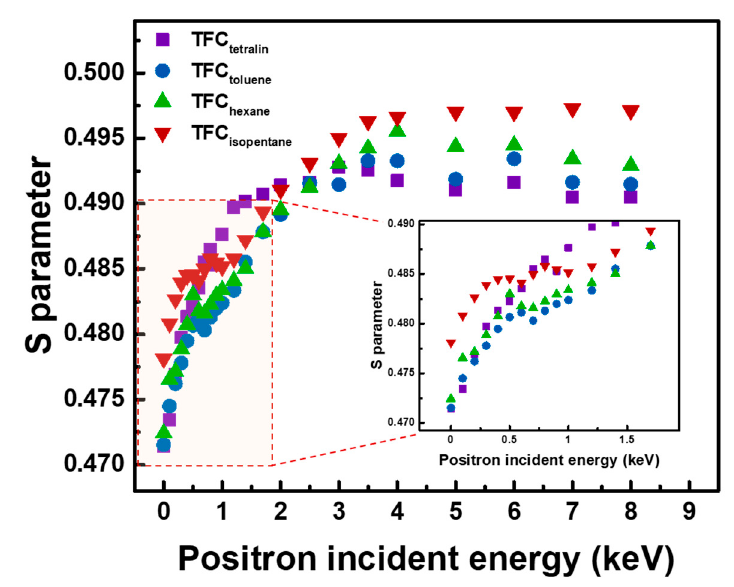
Figure 5. S parameter as a function of positron incident energy of TFC membranes.